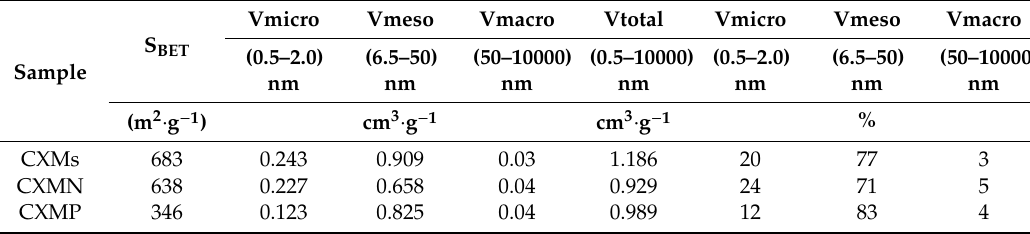
Figure 1. SEM micrographs for the internal structure of carbon xerogel microspheres (CXMs) and the CXMs functionalized with melamine (CXMN) and phosphoric acid (CXMP). Table 2. Textural properties of surface area (S BET ), and volume of micro-pores (Vmicro), mesopores (Vmeso), macro-pores (Vmacro), and total pore volume (Vtotal) for carbon xerogel microspheres (CXMs) and CXMs functionalized with melamine (CXMN) and phosphoric acid (CXMP).